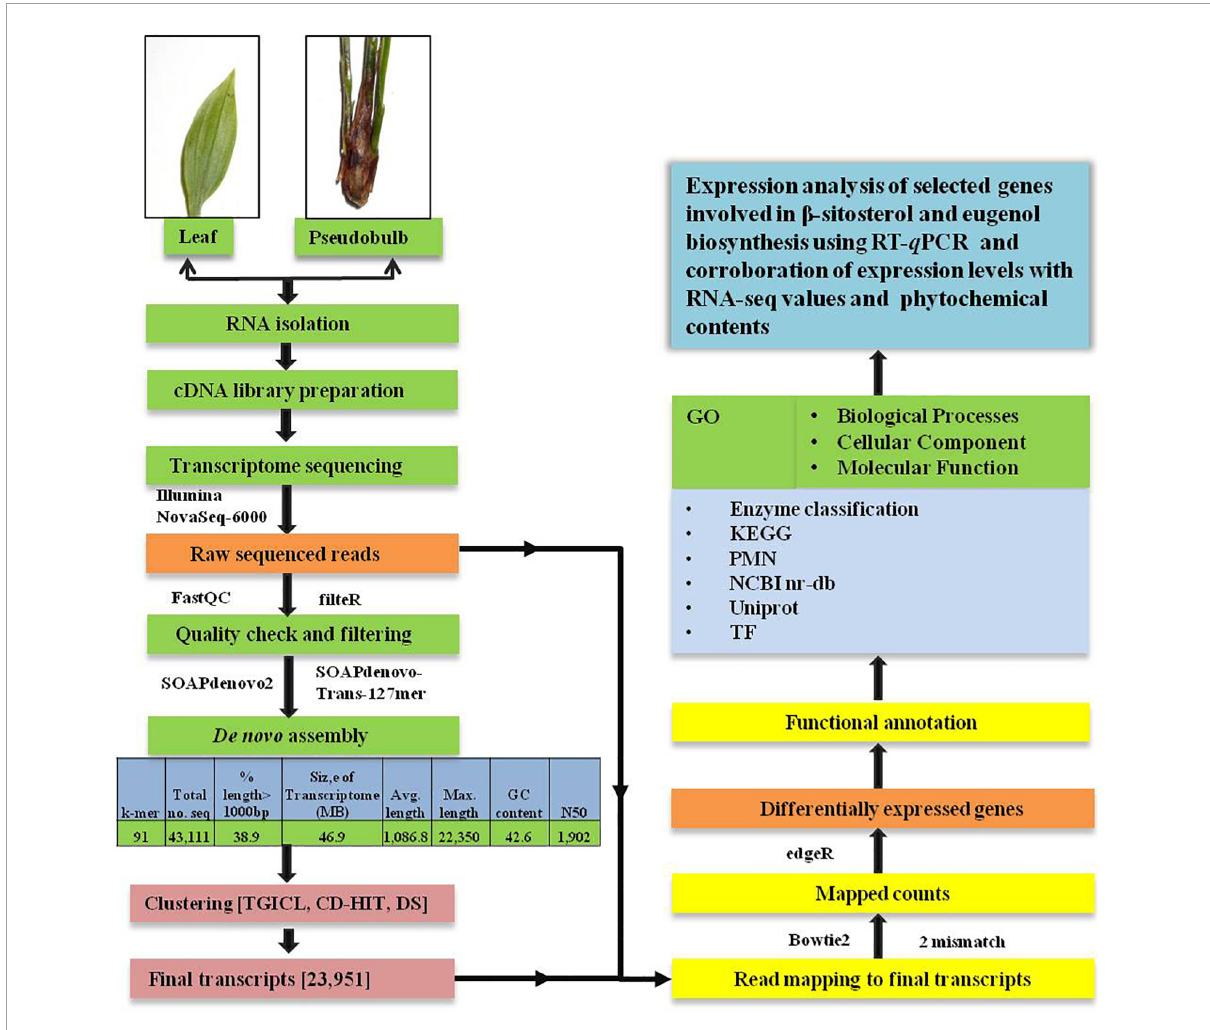
FIGURE1 Schematic representation of workflow used for de novo transcriptome analysis and annotation of high throughput data of M. acuminata